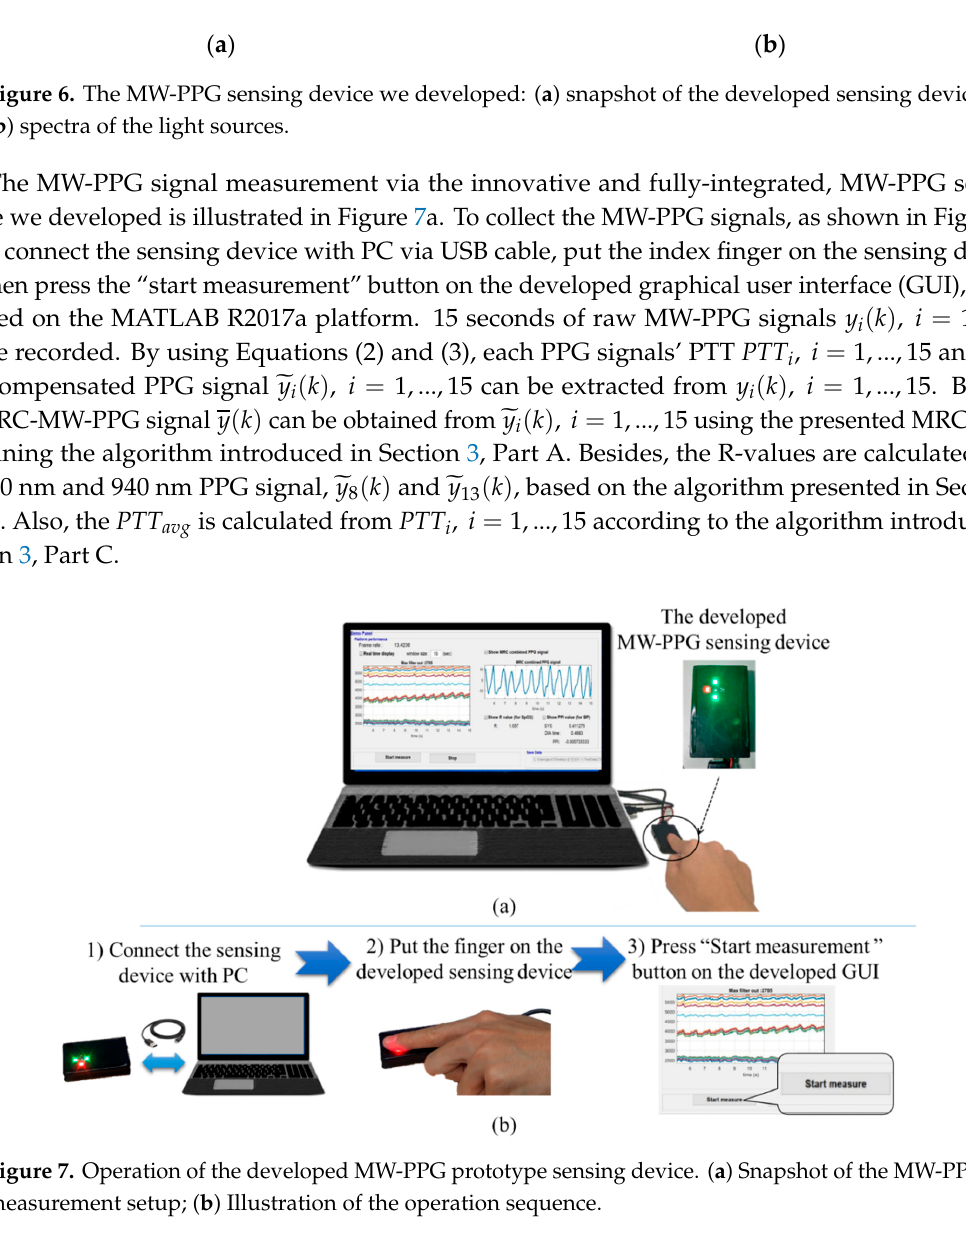
Figure 6. The MW-PPG sensing device we developed: ( a ) snapshot of the developed sensing device; ( b ) spectra of the light sources. ( b ) spectra of the light sources.